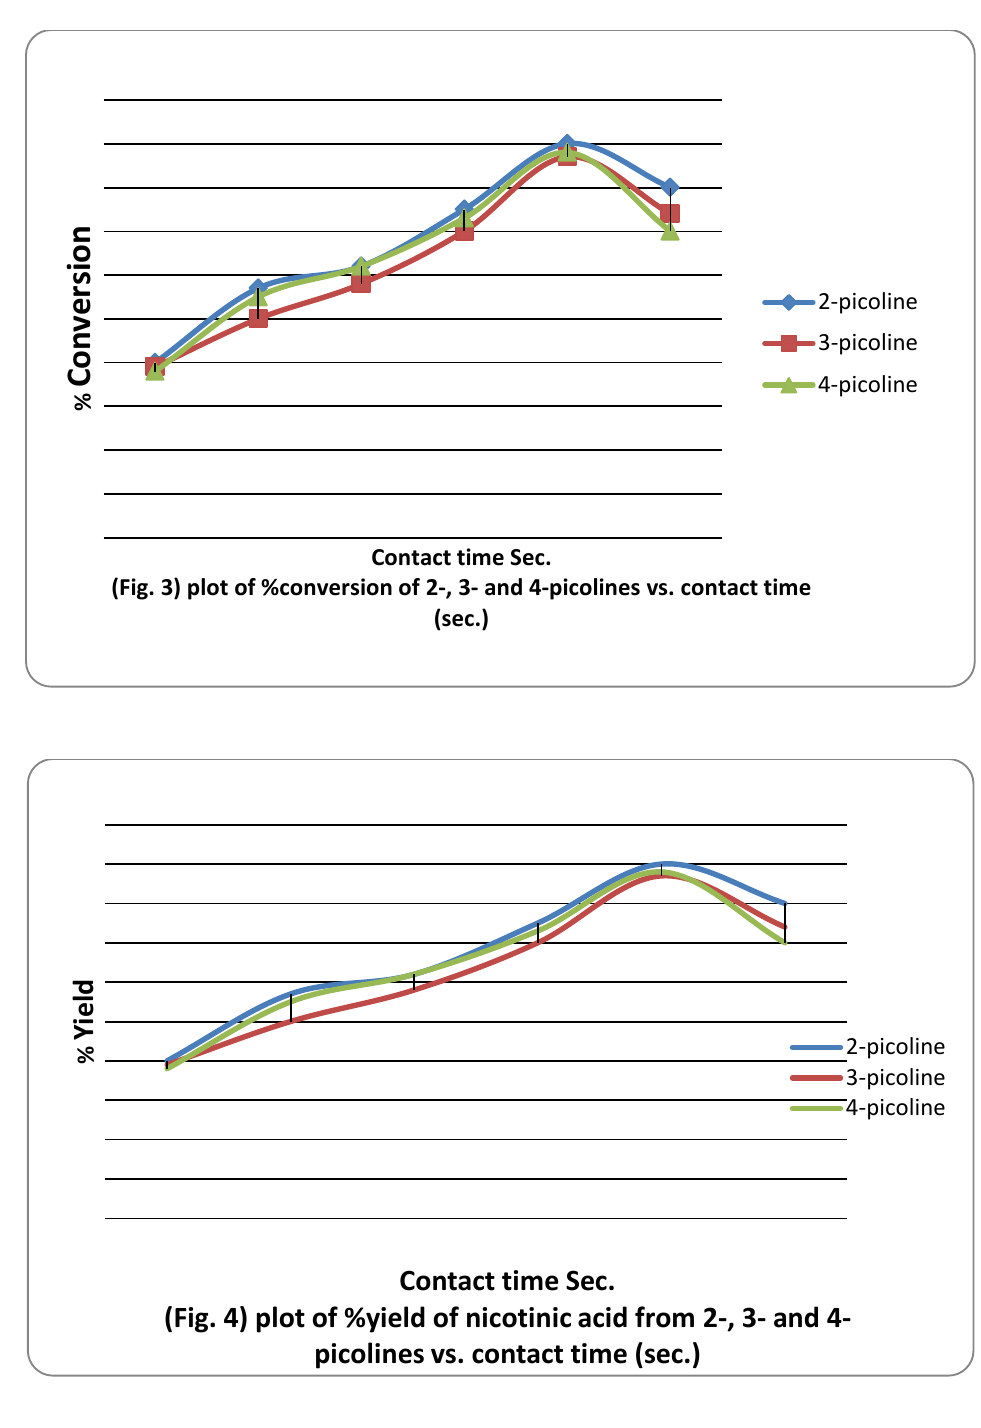
Contact time Sec. (Fig. 4) plot of %yield of nicotinic acid from 2-, 3- and 4- picolines vs. contact time